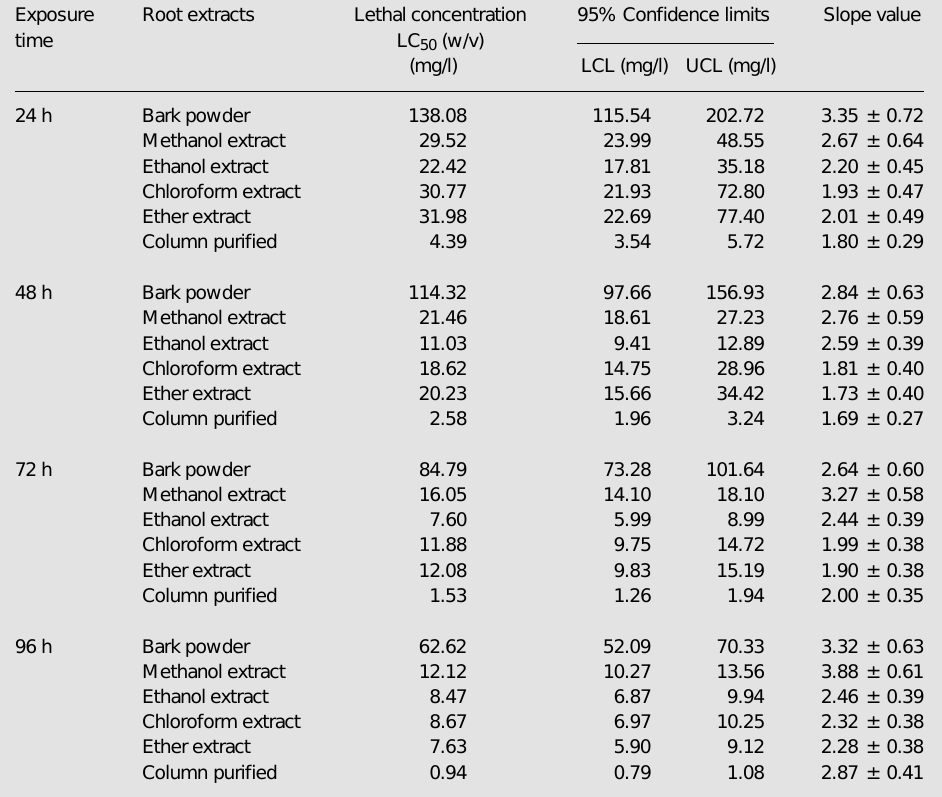
Table 2 - Toxicity (LC 50 ) of extracts of Punica granatum bark against the snail Lymnaea acuminata. Batches of 10 snails were exposed to different concentrations of the extract. Mortality was determined every 24 h. Each set of experiments was replicated six times. Concentrations given are the final concentrations (mg/ l) in the aquarium water. The t-ratio was >1.96, the heterogeneity factor <1.0, and the g value <0.5 at all probability levels. LCL, Lower confidence limit; UCL, upper confidence limit. The slope value is reported as mean ± SEM. Significant negative regression (P<0.05) was observed between exposure time and LC 50 of treatments. Testing significance of the regression coefficient - bark powder, 26.60 + ; methanol extract, 8.75 + ; ethanol extract, 4.27 ++ ; chloroform extract, 12.5 ++ ; ether extract, 7.03 + ; column purified, 7.70 ++ . + Linear regression between x and y; ++ nonlinear regression between log x and log